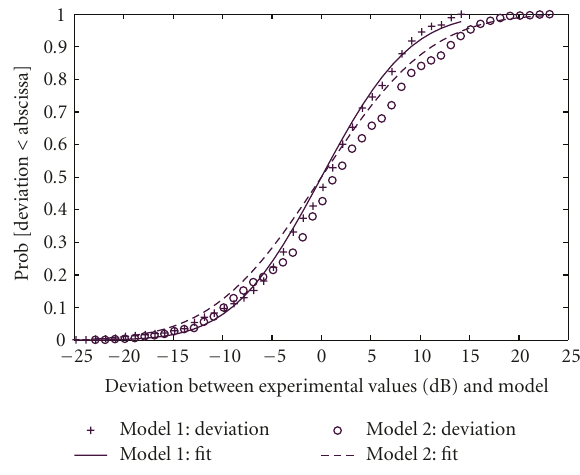
Figure 5: Cumulative distributions of the deviations between experimental data and models 1 and 2, and the linear regression fits for these